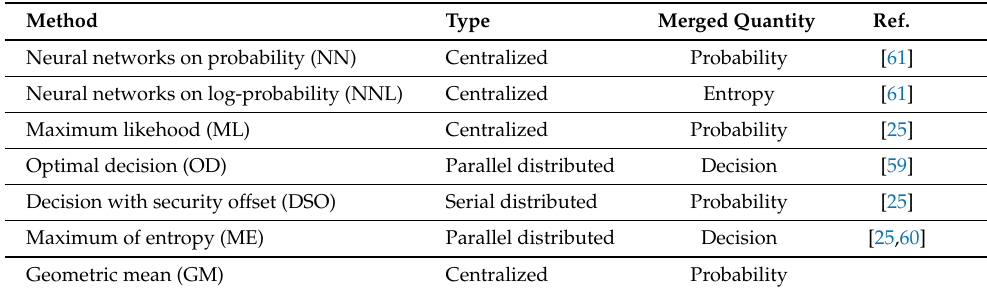
Table 2. Tested methods of HT